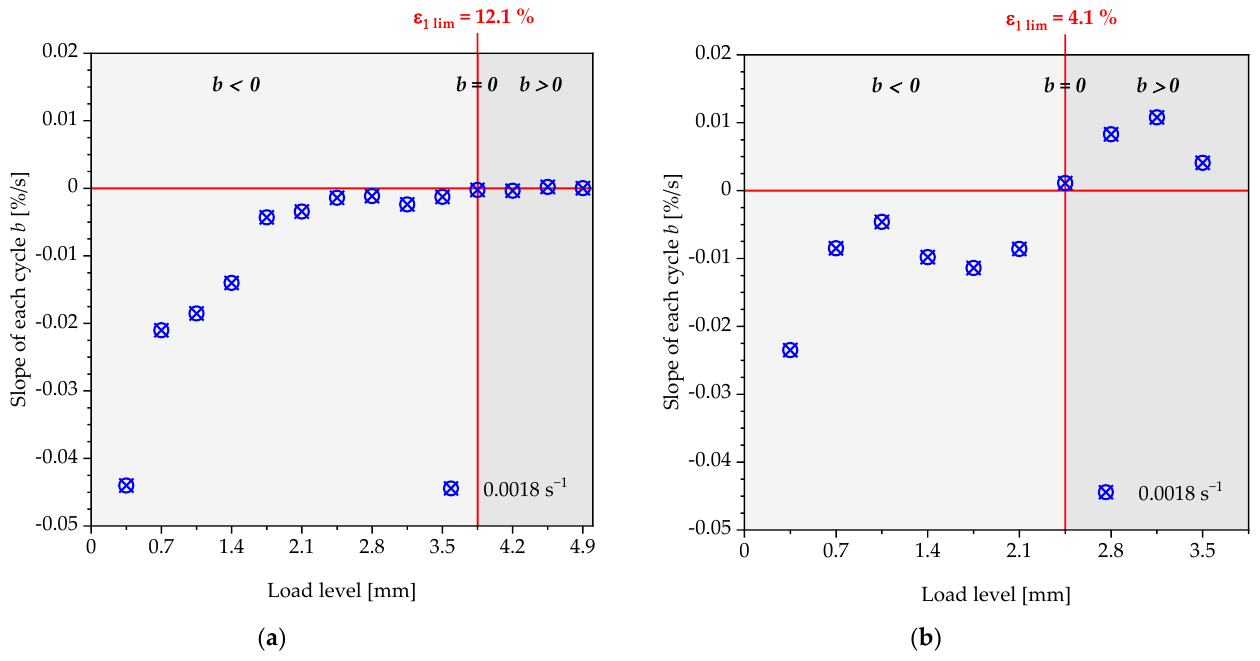
Figure 14. Plot of the slopes of the residual energy ratio curve within the specific load levels ’ respective strain levels for the polyurethane systems ( a ) Neukadur ® and ( b ) puroclear ® under simple shear load.